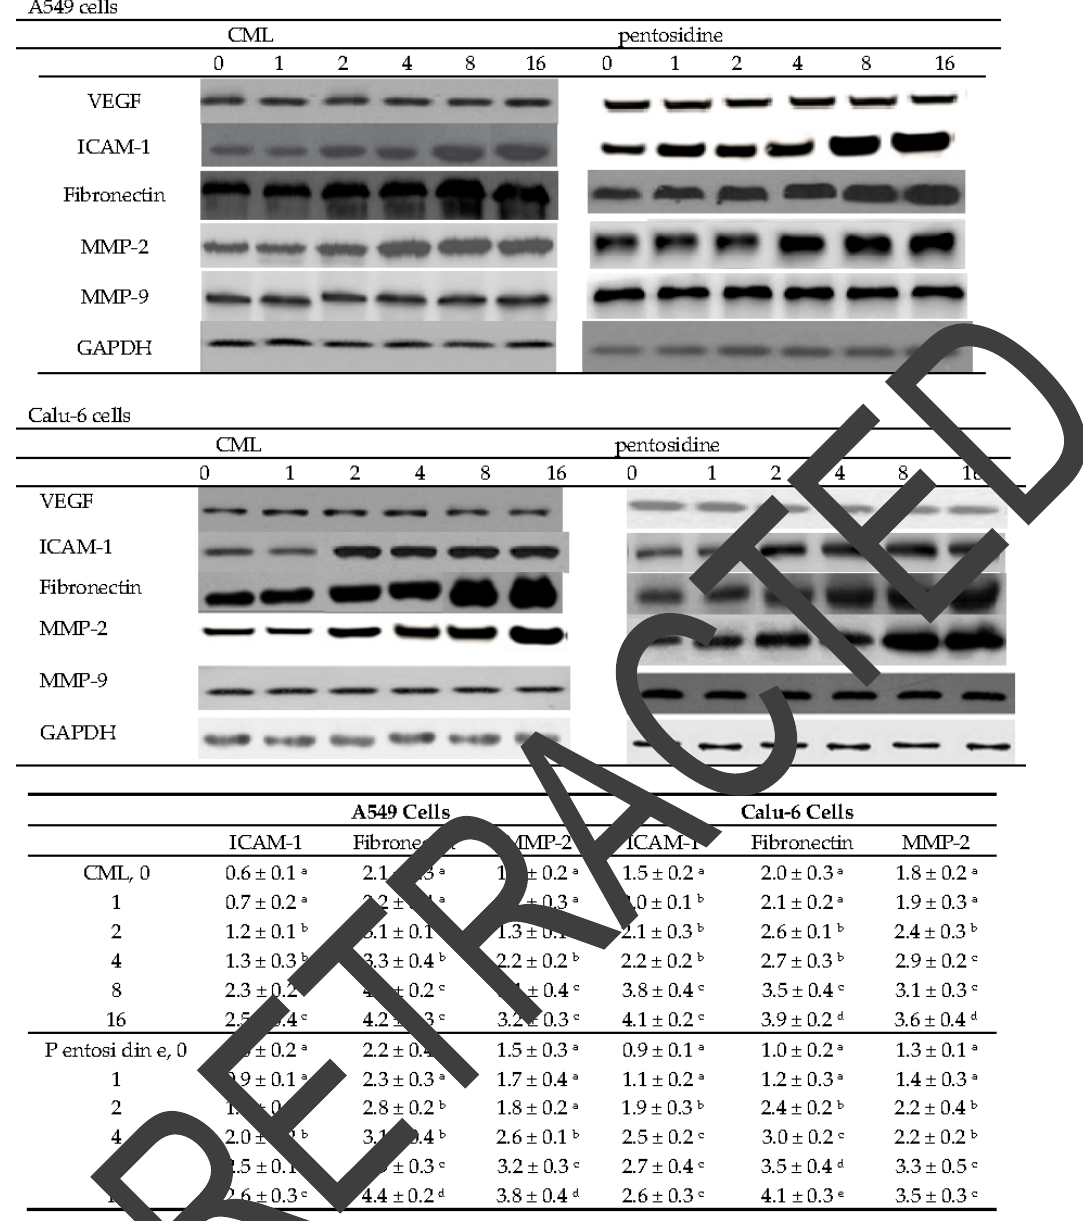
Figure 3. Effects of CML or pentosidine at 0 (control), 1, 2, 4, 8 or 16 μ mol/L upon protein expression of VEGF, ICAM-1, fibronectin, MMP-2 and MMP-9 in human A549 and Calu-6 cells. Cells were exposed to CML or pentosidine for 18 h at 37 °C. Data are mean ± SD ( n = 10) and shown in the following table. a–e Means within a column without a common letter differ, p < 0.05.